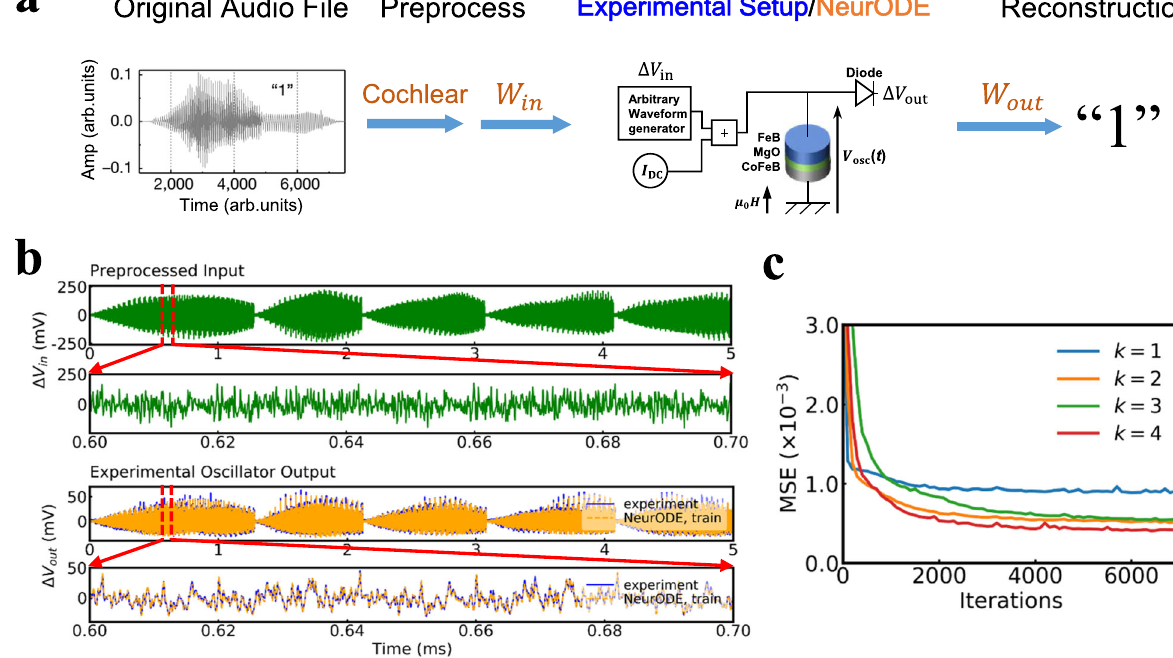
Fig. 4 Prediction of experimental results using Neural ODEs (train results). a Principle of the experiment. The original spoken digit in the audio waveform is preprocessed, by cochlear or spectrogram fi ltering, to form the preprocessed input into the oscillator. The output of the digit is reconstructed by reading out the recorded oscillator output through a trained matrix W out (see Methods section). The purpose of modeling is to predict the experimental oscillator output given any preprocessed input Δ V in . This Figure shows the results obtained using cochlear fi ltering (results using spectrogram fi ltering are reported in Suppl. Fig. 8). b Training output trajectory of voltage Δ V out predicted by Neural ODE (dashed orange) with corresponding preprocessed input Δ V in , in comparison with the experimental measurement (blue) for k = 2. A training set of 5-ms dynamics is adopted from the fi rst utterance of the fi rst speaker. A three-layer neural network f θ with each hidden layer of 100 units is trained. c Training loss (MSE) of Neural ODE with k = 1, 2, 3, 4 as a function of